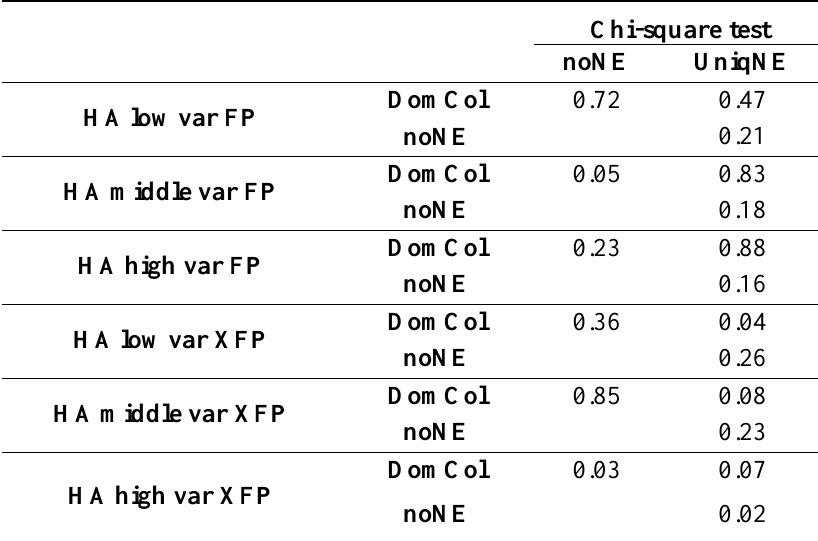
Table 5. Comparison of games with the same key features and different strategic structures ( p